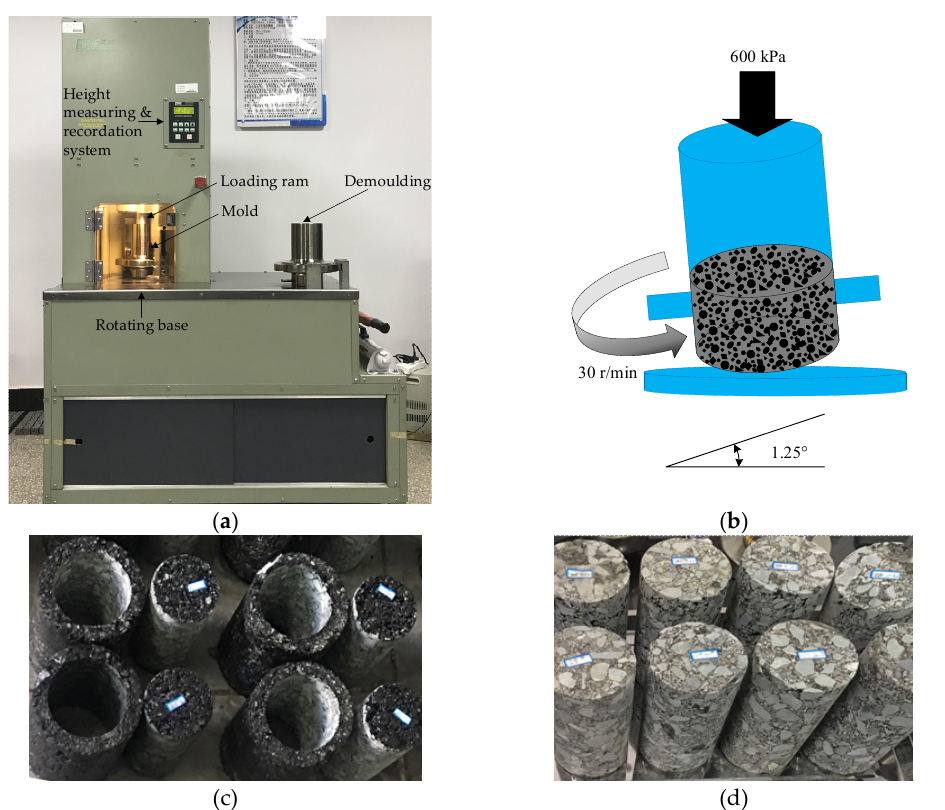
Figure 3. Diagram of Superpave gyratory compaction (SGC) in this paper: ( a ) Superpave gyratory compaction; ( b ) parameters; ( c ) SGC specimens and ( d ) core samples.